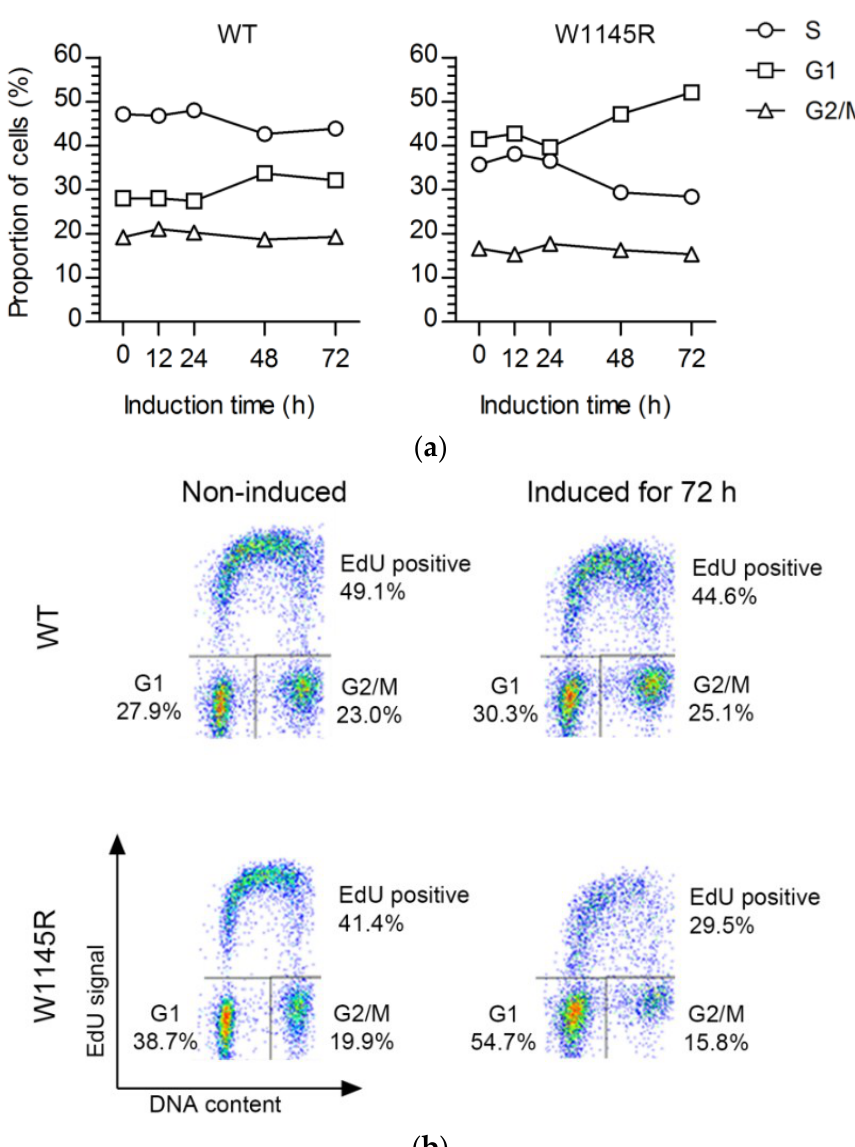
Figure 3. Cells expressing eGFP-TopBP1 W1145R arrest predominantly in gap 1 (G1) phase. ( a ) Flow cytometry analysis of cells. Cells were induced to express eGFP-TopBP1 WT or W1145R for the indicated times, and were pulsed with 5-ethynyl-2′-deoxyuridine (EdU) prior to sample collection to label synthesis (S)-phase cells. ( b ) Flow cytometry profiles of selected samples from panel A.